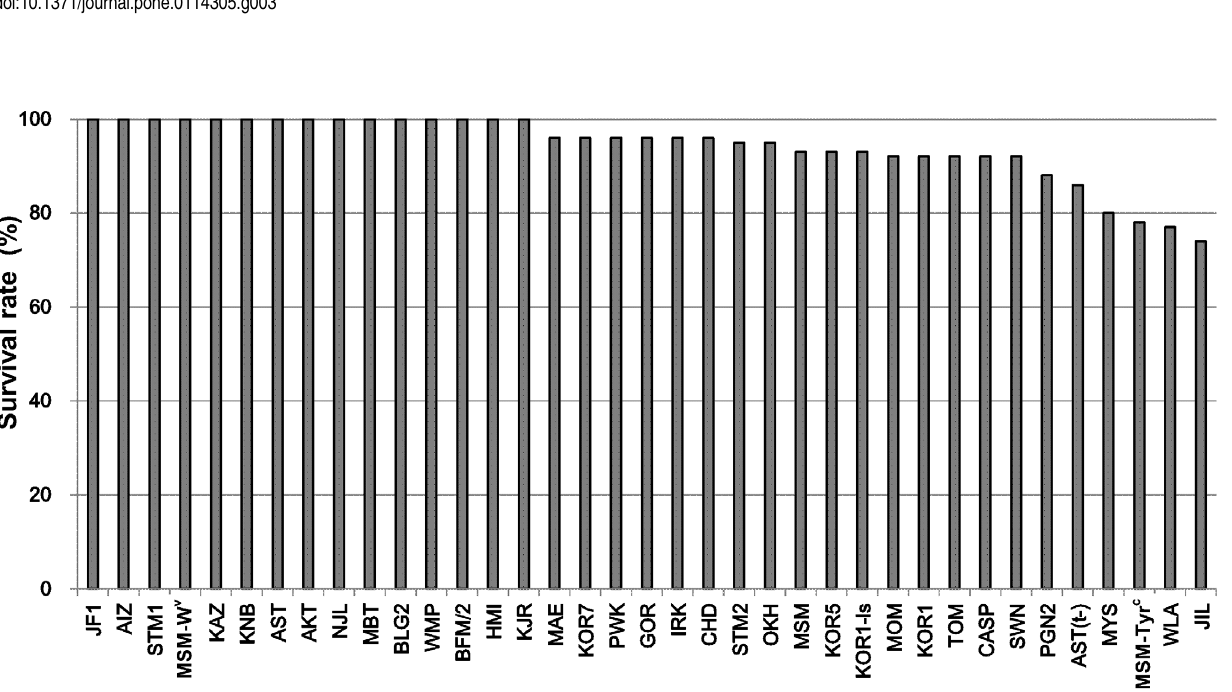
Figure 3. Fertilization rates after IVF with fresh (gray) or frozen (black) spermatozoa. Strains are placed in the order of the fertilization rates using frozen spermatozoa. The detailed data set is available in Table S5. N.T., not tested. Error bars 5 S.E.M.